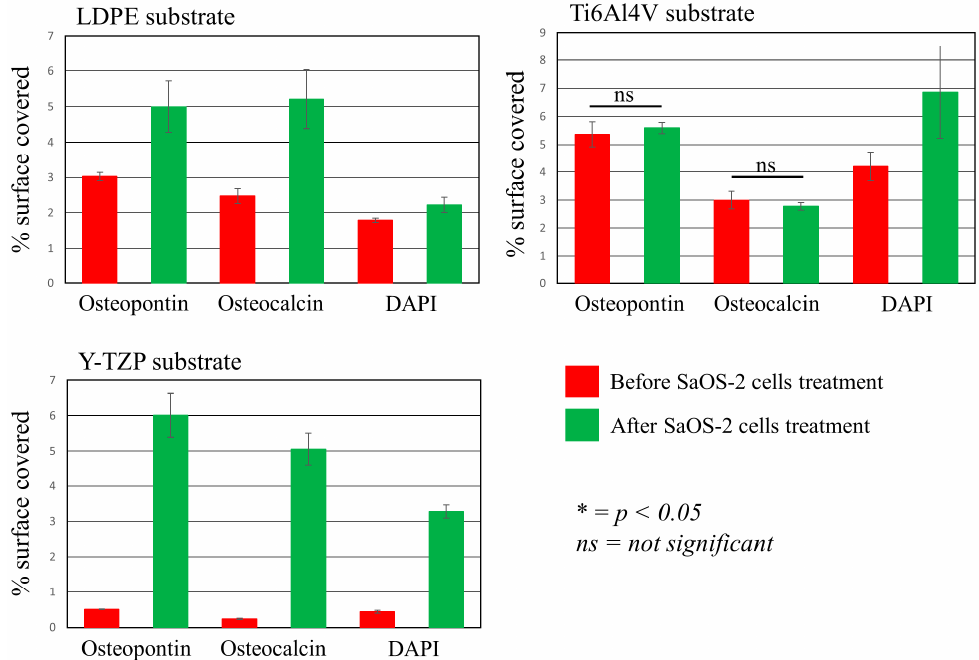
Figure 11. Relative surface substrate amounts assigned to the fluorescent probes used for osteocalcin, osteopontin, and cell nuclei based on fluorescence micrograph